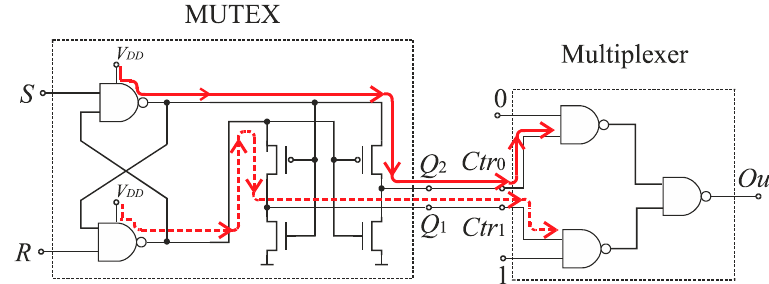
Figure 34. Symmetrical control of both channels of symmetrized multiplexer.